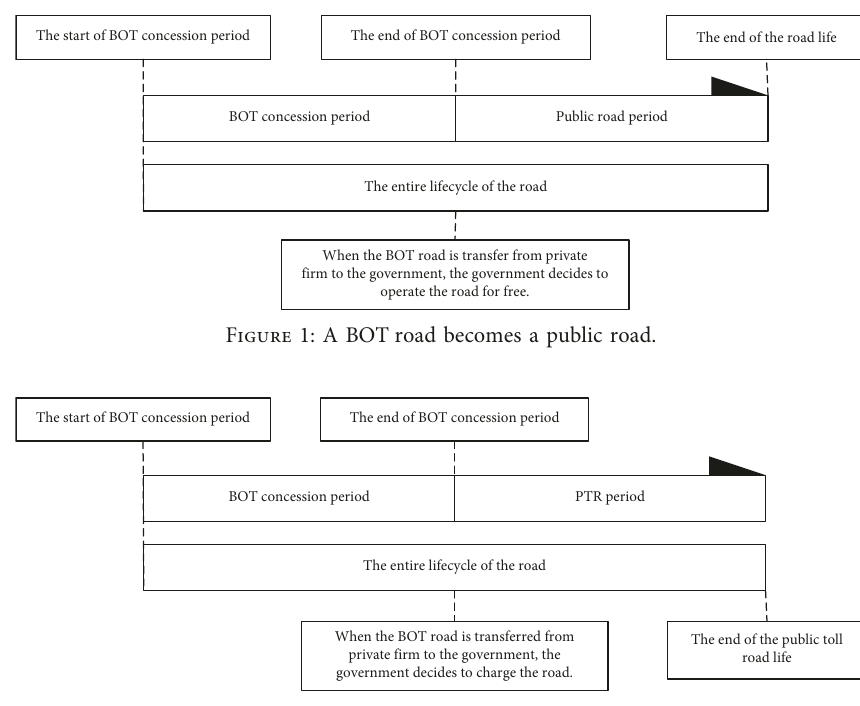
Figure 2: A BOT road becomes a public toll road